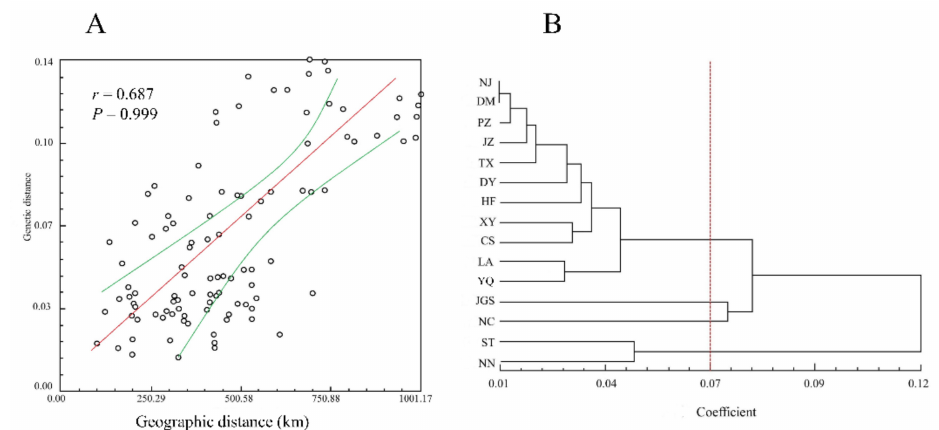
Figure 5. Mantel test between genetic distance and geographic distance of M. azedarach provenances ( A ) and UPGMA dendrogram of M. azedarach provenances ( B ). DY: Dongying, Shandong